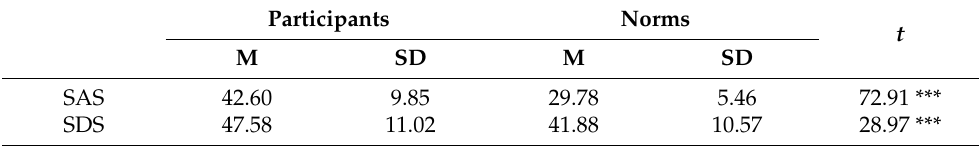
Table 1. Postgraduate Anxiety and Depression Description Statistics.